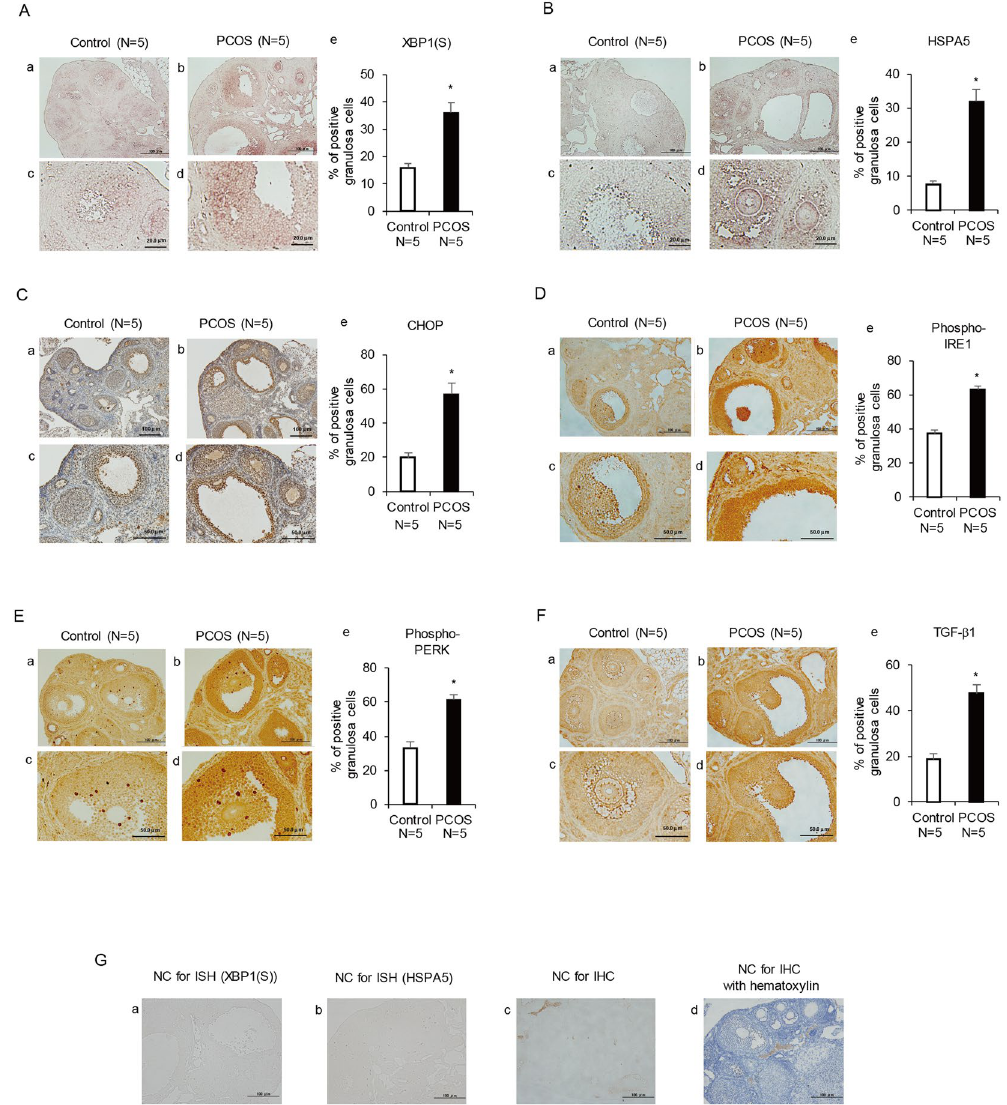
Figure 3. XBP1(S) and HSPA5 mRNA expression levels, and CHOP, phospho-IRE1, phospho-PERK, and TGF- β 1 protein expression levels in ovaries of control and PCOS mice. Three-week-old female mice were divided into two groups. The control group (n = 5) was s.c. injected daily with sesame oil for 20 days. The PCOS group (n = 5) was s.c. injected daily with DHEA (6 mg/100 g of body weight) for 20 days. The ovaries were collected on day 21. ( A , B ) Cross-sections of ovaries from control and PCOS mice were hybridized with a DIG-labeled antisense XBP1(S) or HSPA5 probe. ( C – F ) Cross-sections of ovaries from control and PCOS mice were stained with an anti-CHOP antibody counterstained with hematoxylin, or an anti-phospho-IRE1, anti-phospho-PERK, or anti-TGF- β 1 antibody. ( G ) Controls for background level (a,b) hybridized with sense probe, (c) stained with isotype IgG, and (d) stained with isotype IgG and hematoxylin. ( A – F ) (a–d) show the representative sections. Lower panels (c,d) show highly magnified views corresponding to (a,b). (e) show the quantitative analysis of ( A , B ) in situ hybridization and ( C – F ) immunohistochemical staining. The scale bars in ( A – F ) (a,b) and ( G ) (a–d) indicate 100 μ m. The scale bars in ( A , B ) (c,d) and ( C – F ) (c,d) indicate 20 μ m and 50 μ m, respectively. * p < 0.05. NC, negative control; ISH, in situ hybridization; IHC,